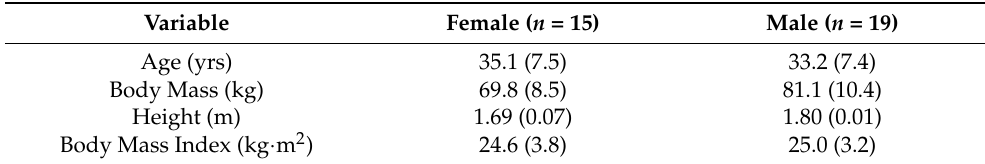
Table 1. Descriptive statistics for female and male firefighters. Values presented as mean (standard deviation).